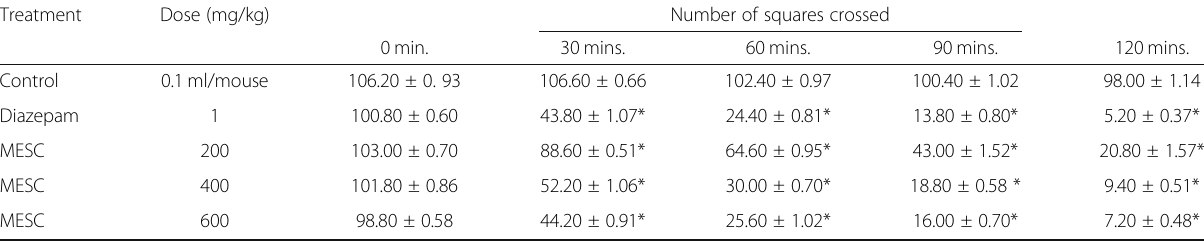
Table 2 The sedative effect of MESC on the open field test in mice